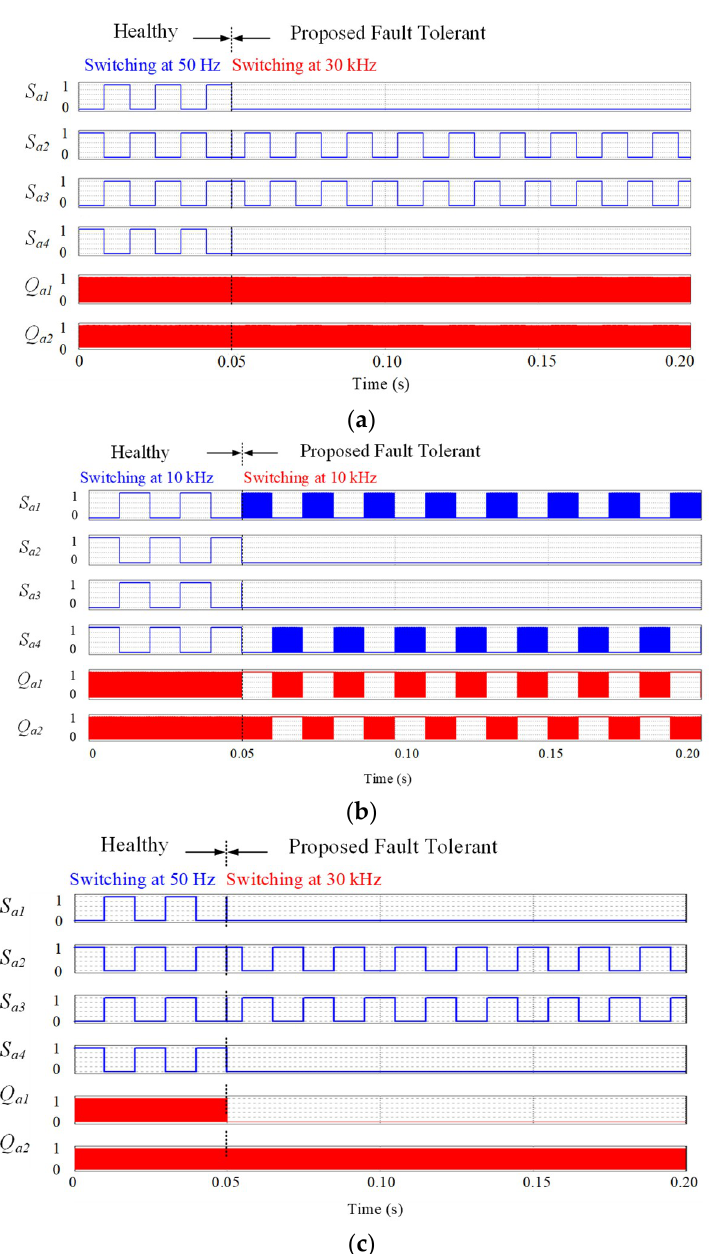
Figure 11. Proposed switching sequences after an open-circuit fault occurred at ( a ) S a1 /D a1 , ( b ) S a2 /D a2 , and ( c ) Q a1 /D Qa1 .